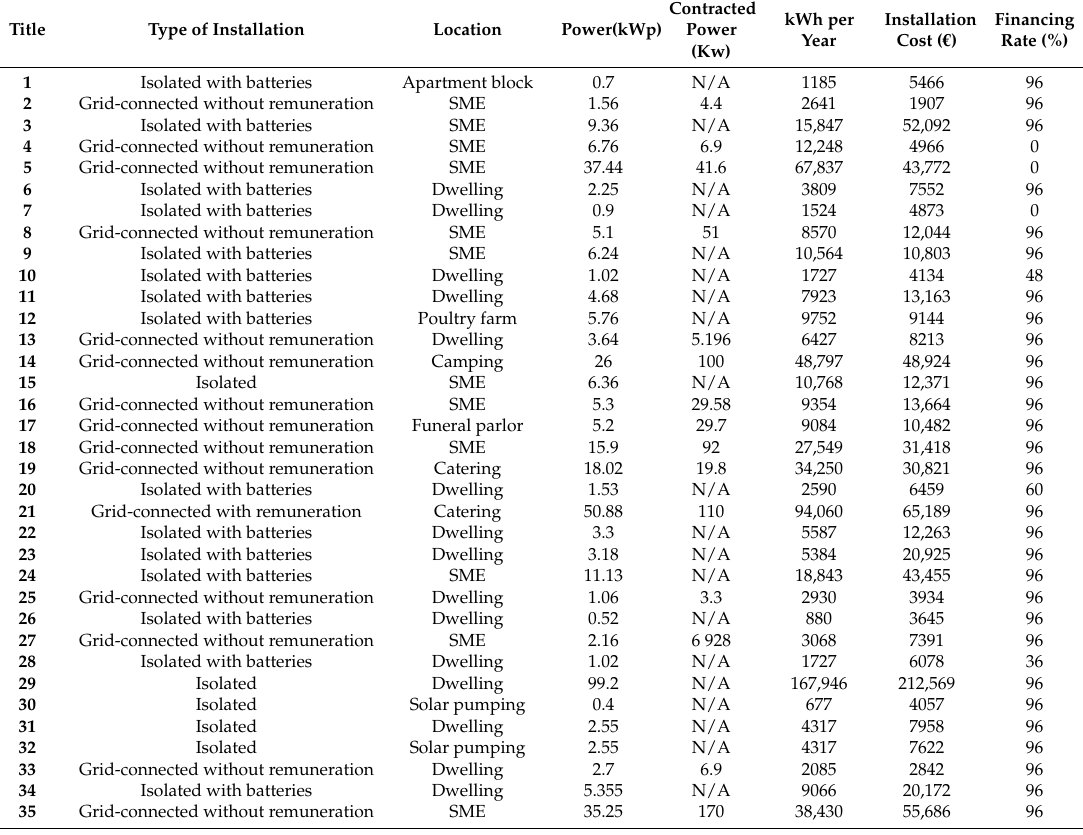
Table A2. Main characteristics of the self-consumption installations under